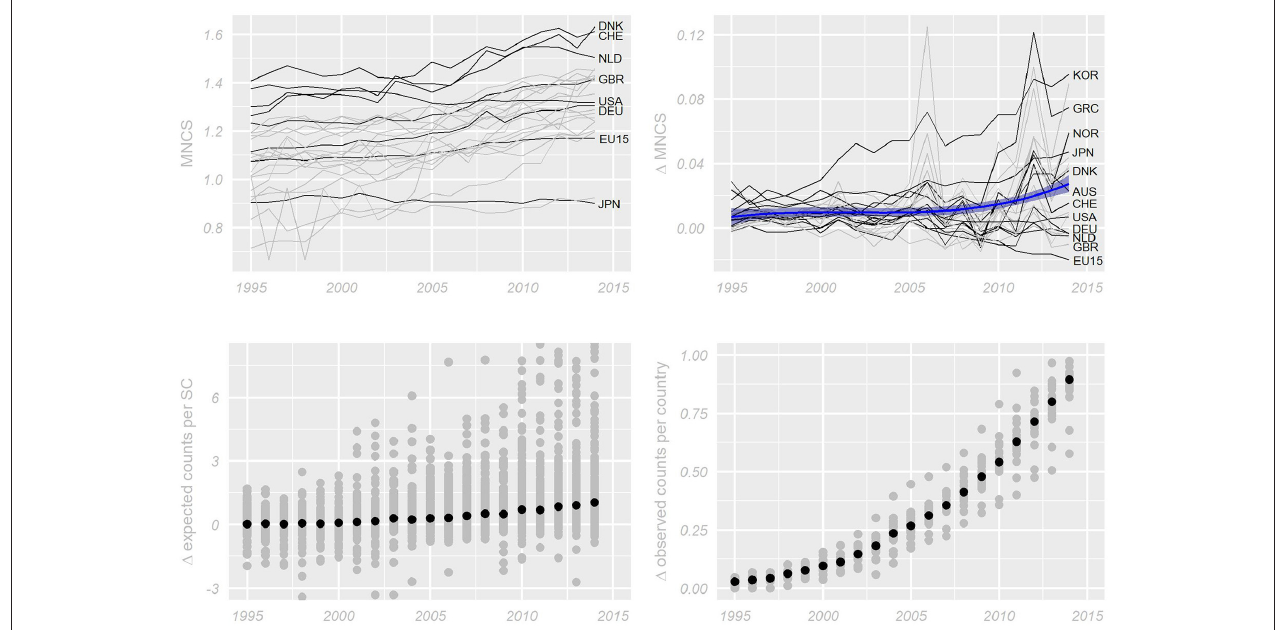
FIGURE 2 | (Upper left panel) Actual national MNCS values; (Upper right panel) changes in MNCS; (Lower left panel) differences in expected counts; (Lower right panel) differences in observed citations.